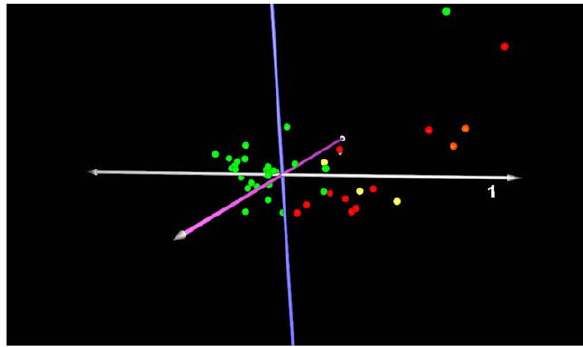
Figure 2. Principal component analysis of severe IPF (D L CO # 35% predicted). Red spheres: definite IPF; Orange spheres: probable IPF; Yellow spheres: unclassifiable fibrosis; Green spheres: healthy controls . Axis labels: white-first principal component; blue- second principal component; lavender- third principal component. The majority of severe cases, both probable and definite, cluster along the first principal component. Three cases of unclassifiable fibrosis distribute with IPF cases.